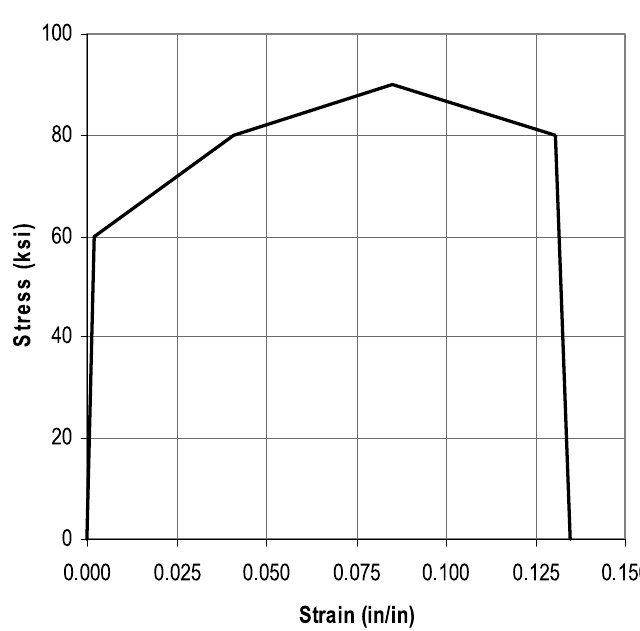
Fig. 3. High-strength concrete material properties.